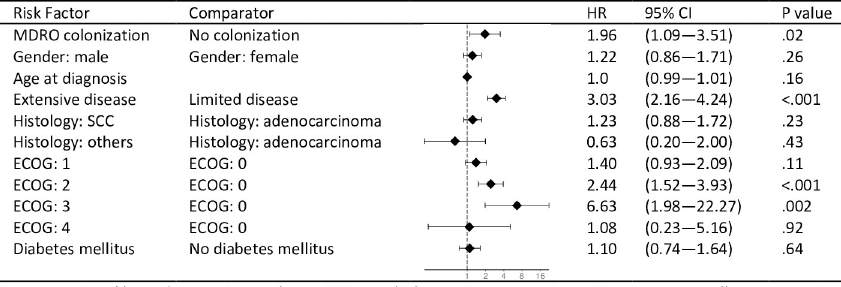
Fig 3. Multivariate analysis of risk factors for death.